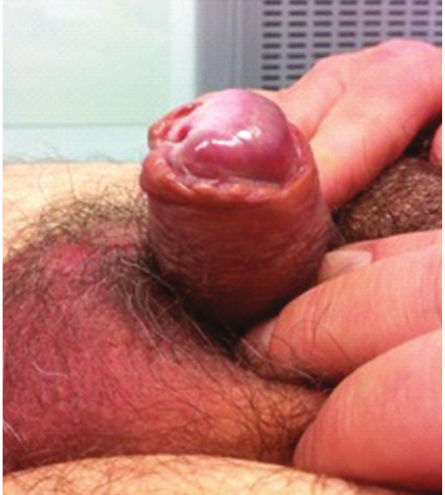
Figure 5: At the end physical examination, the penis appeared well vascularized once again and